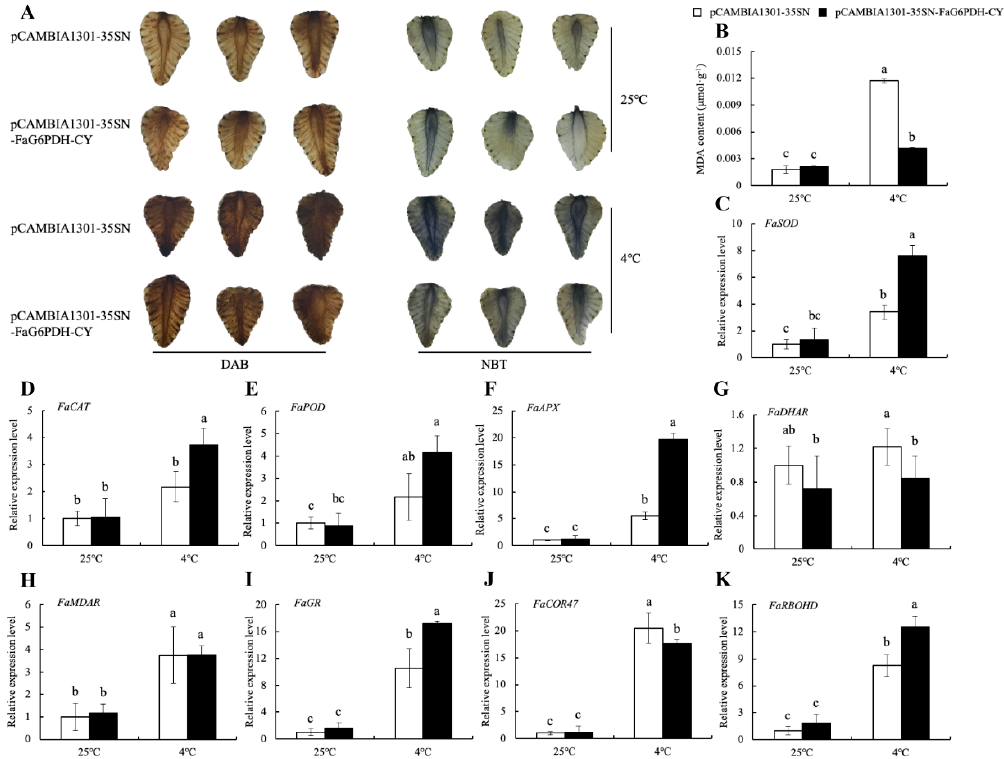
Figure 6. E ff ect of FaG6PDH-CY overexpressing on strawberry fruits in response to cold stress. Overexpressing strawberries were sampled after 5-day treatment at 4 ◦ C and 25 ◦ C to detect ROS production ( A ), MDA content ( B ) and gene expression ( C–K ). H 2 O 2 was indicated by the presence of deep brown using 3, 3-diaminobenzidine (DAB) staining. O 2 − was indicated by the presence of dark blue using nitrobluetetrazolium (NBT) staining. Di ff erent lowercase letters indicate significant di ff erences at p <